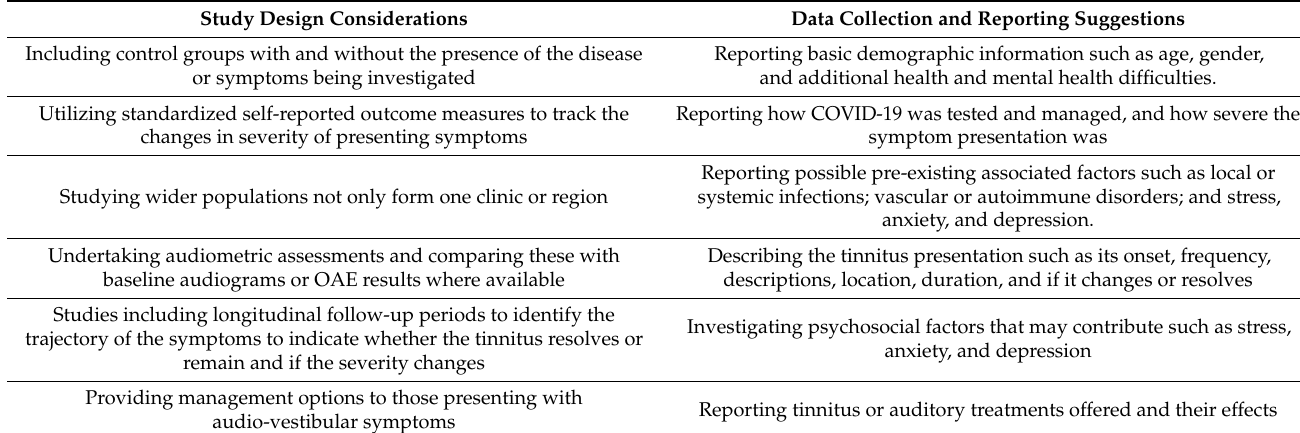
Table 5. Recommendations for future research investigating the impact of COVID-19 on audio-vestibular conditions. Study Design